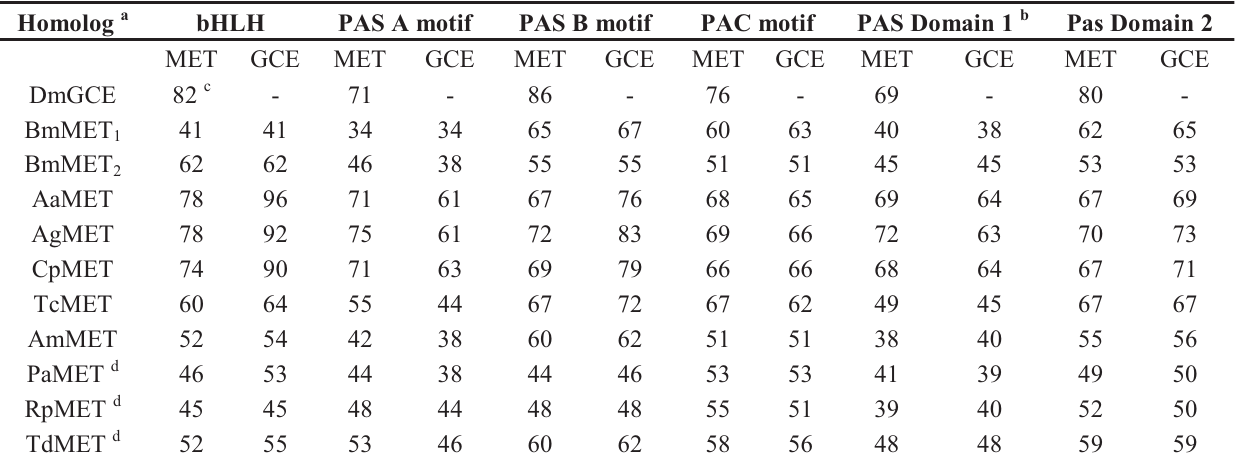
Table 1. Conservation of Drosophila Methoprene-tolerant (MET)/germ cell-expressed (GCE) sequence among insect